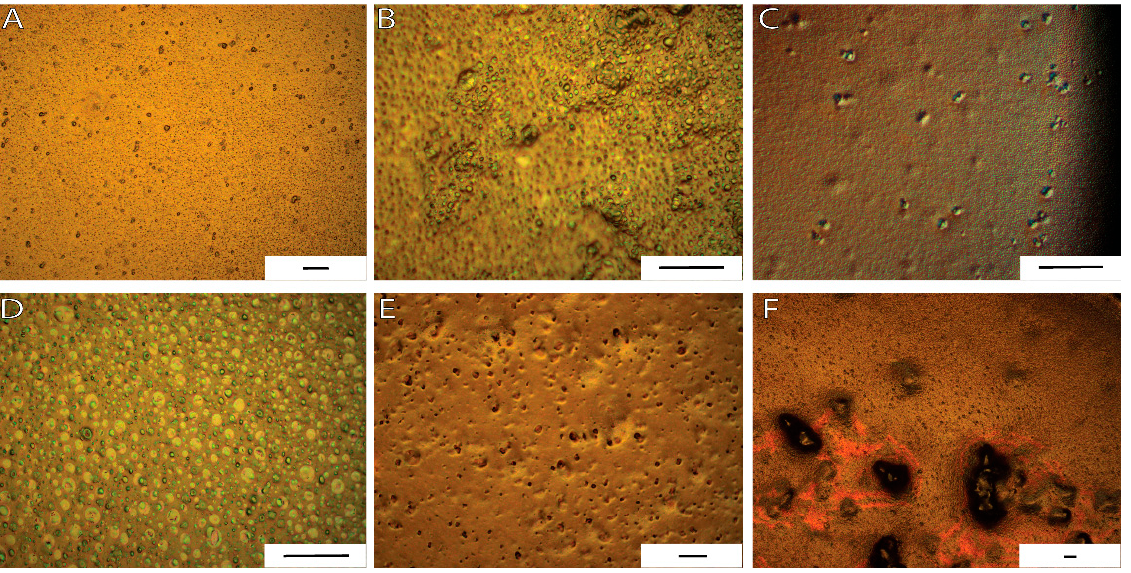
Figure 1. Polarized optical light micrographs of solvent casted polymer films: ( A ) AL-1; ( B ) AL-2; ( C ) AL-3; ( D ) AL-4, ( E ) LSL-1; and ( F ) LSL-2, revealed phase separation and aggregation of lignin within PAN-co-MA. [Scale bar = 50 microns].